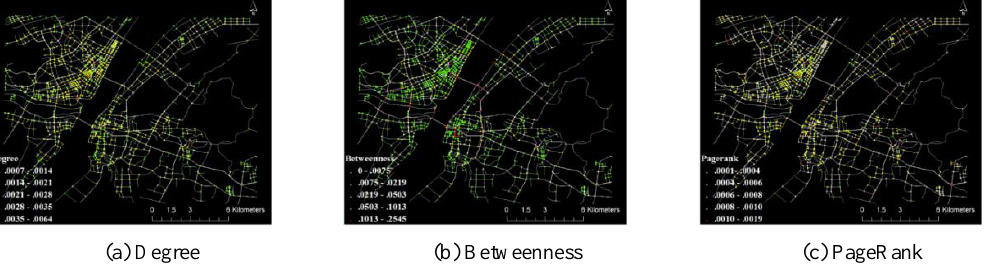
Figure 4. Spatial distribution of centrality in the